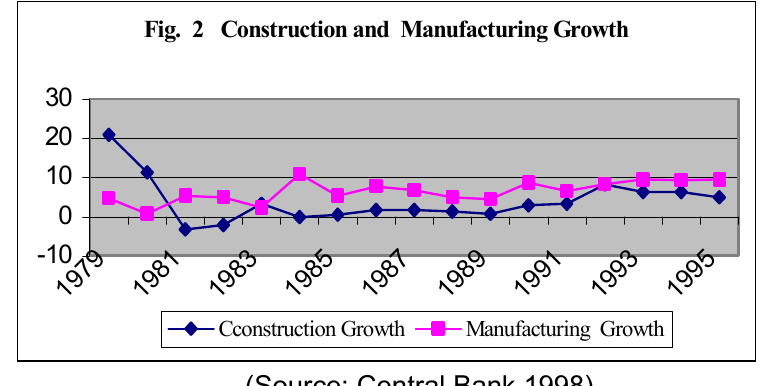
Fig. 3 Construction and GDP growth rate